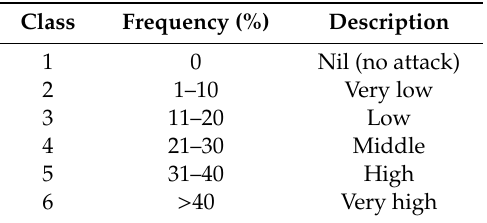
Table 2. Classification of the frequency of termite attacks